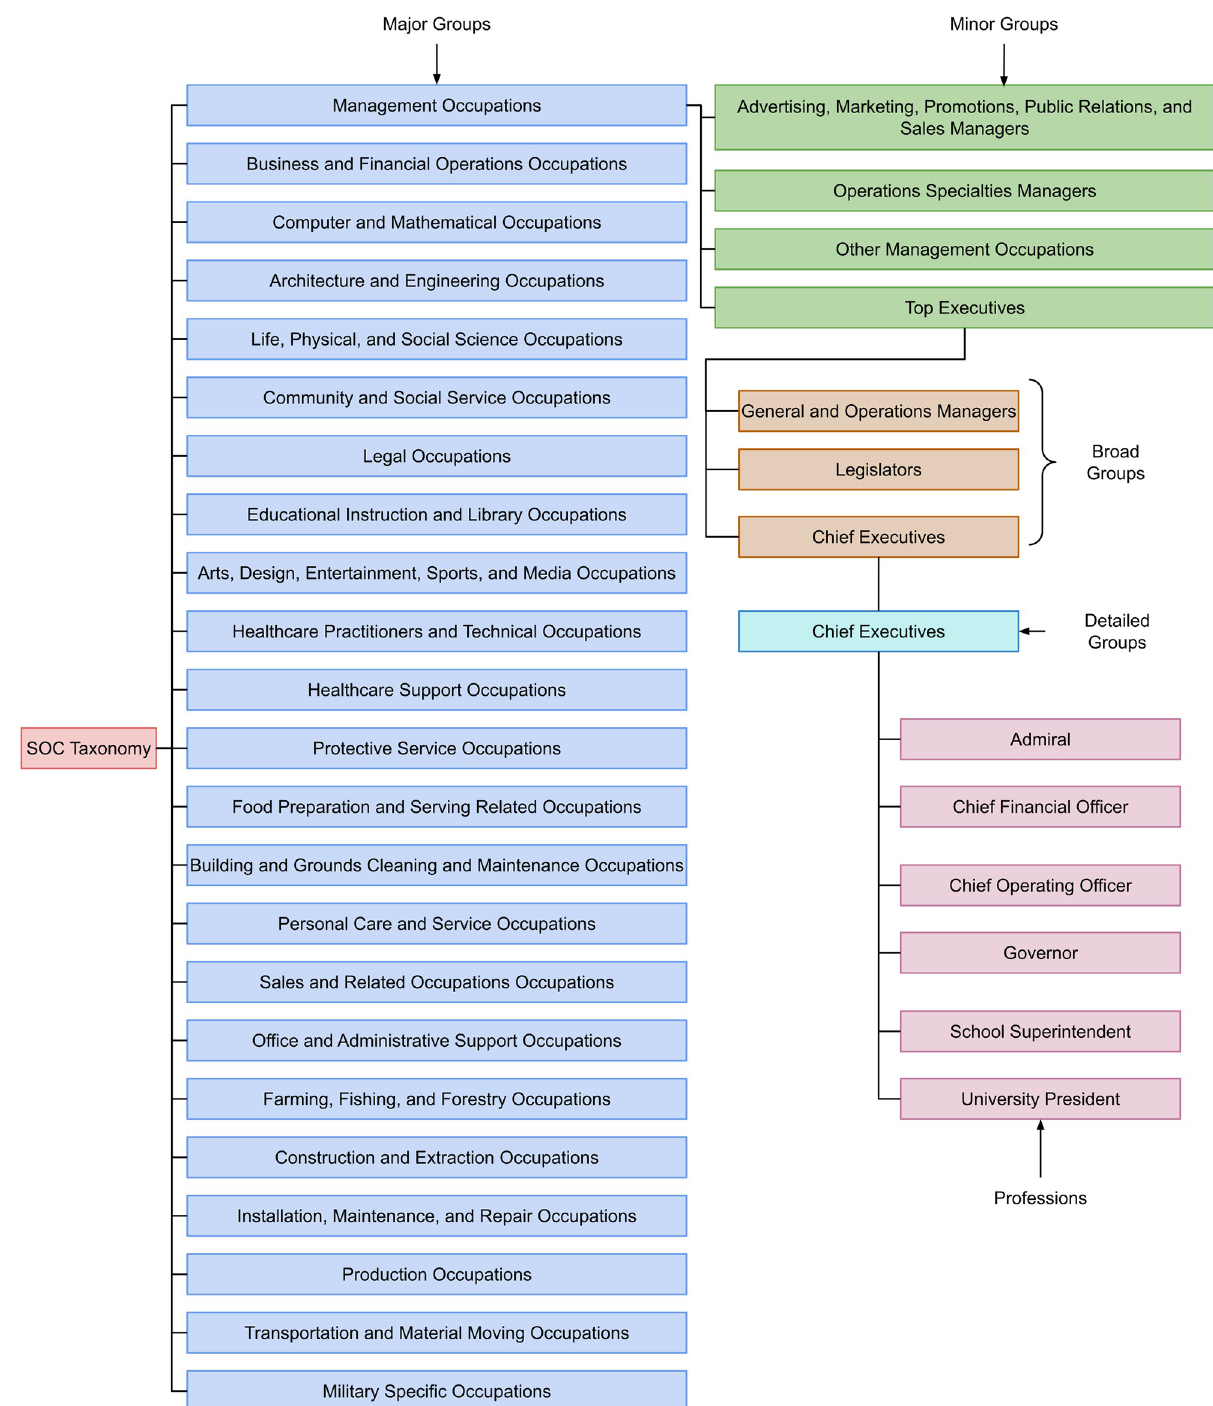
Fig 1. Standard Occupational Classification (SOC) system. The Standard Occupational Classification (SOC) is a 4-tiered profession taxonomy: major, minor, broad, and detailed groups. Detailed groups contain a set of closely-related professions. This figure shows the Management Occupations (major) ! Top Executives (minor) ! Chief Executives (broad) ! Chief Executives (detailed) ! Admiral, Chief Financial Officer, ... , University President (professions) branch.